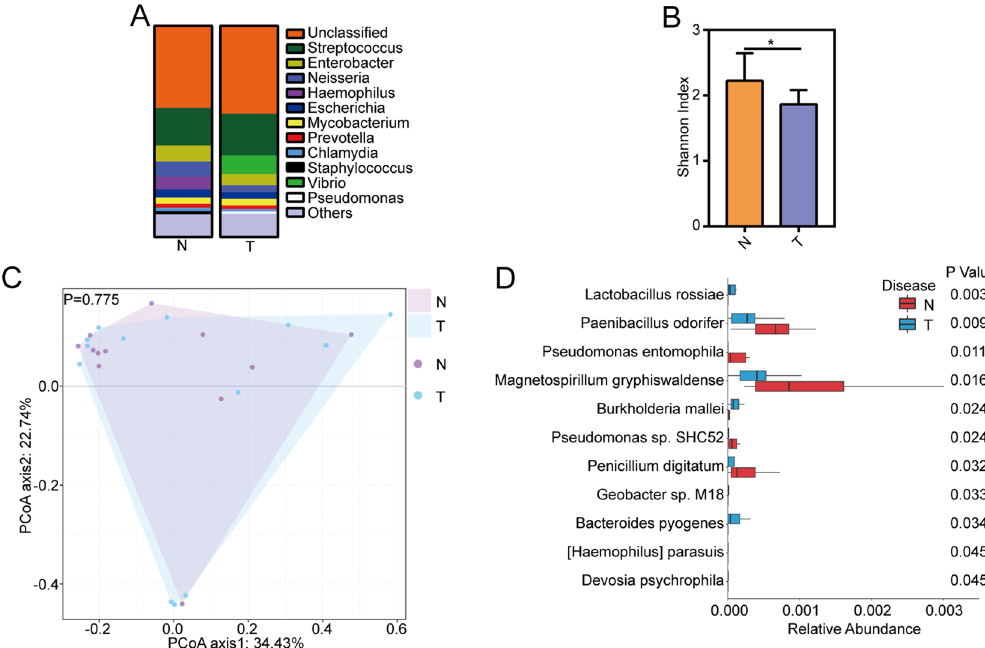
Figure 3. Microbiome composition of NSCLC patients and non-cancer controls in bronchoscopy samples. ( A ) Taxonomic composition of non-human sequences at phylum level in NSCLC patients and non-cancer controls in bronchoscopy samples. ( B ) The Shannon diversity index between NSCLC patients and non-cancer controls in bronchoscopy samples. Difference between sampling methods was determined by Student t test. *p < 0.05. ( C ) PCoA analysis of NSCLC patients and non-cancer controls in bronchoscopy samples. ( D ) The differential species between NSCLC patients and non-cancer controls in bronchoscopy samples were identified by Wilcoxon rank-sum test (p < 0.05). N non-cancer controls, T NSCLC